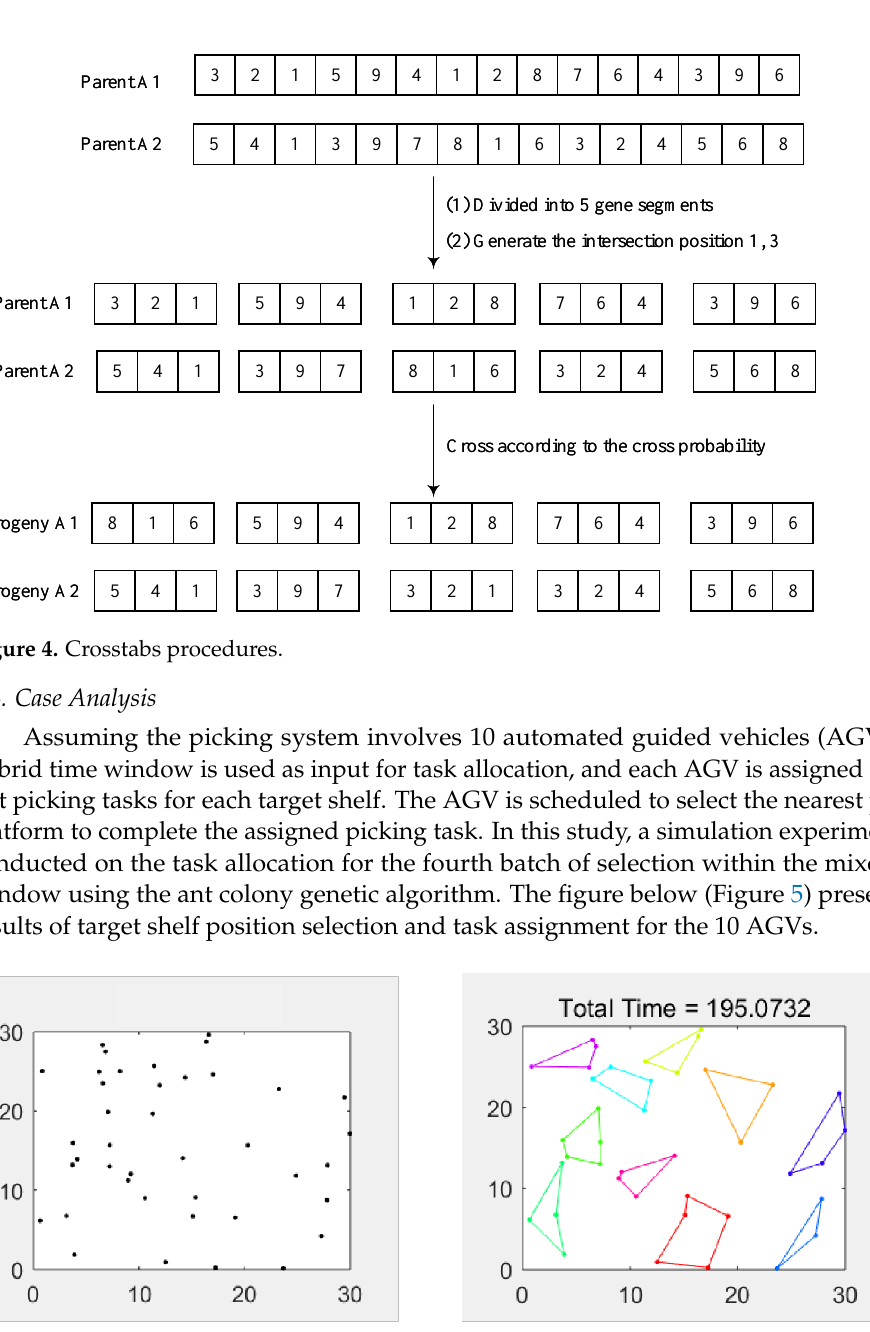
Figure 5. Task assignment results of 10